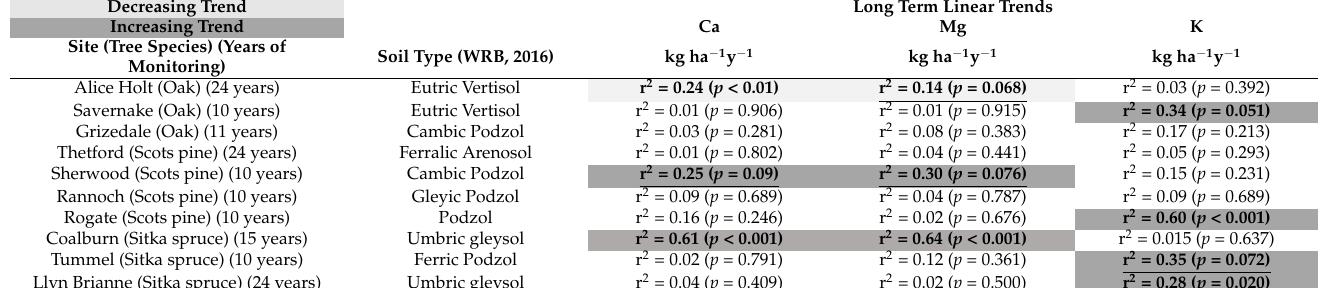
Table 5. Temporal trend analysis for base cation budgets at all ten ICP Forest Level II sites. Linear regressions between cation budgets and time were tested and r 2 and p values are shown. Decreasing trends are highlighted in light grey and increasing trends in dark grey. Significant trends at p < 0.05 are highlighted in bold and marginally significant trends at p < 0.1 are also underlined.